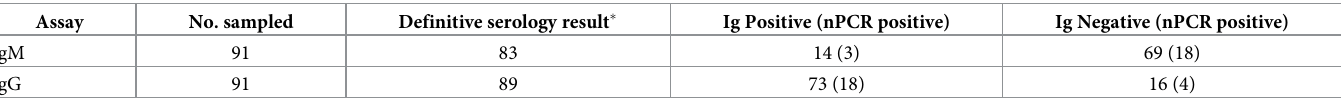
Table 2. Summary of Toxoplasma gondii detection by nested PCR (nPCR) in blood collected from pregnant women subdivided IgM and IgG anti-Toxoplasma serology. Assay No. sampled